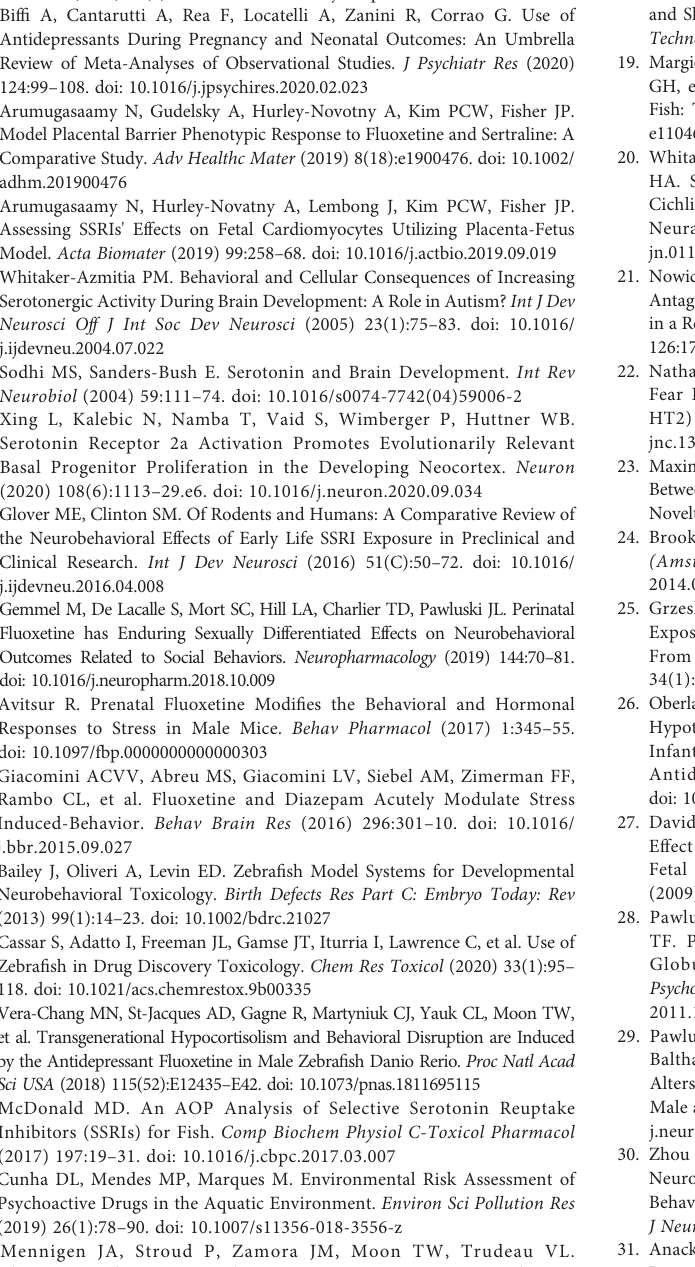
scales of the y-axis are different for unstressed and stressed conditions to illustrate the data points clearly. The blue line shows the adjusted p -value ≤ 0.05 (equal to 1.3 on a negative logarithmic scale). The genes with signi fi cant FC are demonstrated as red dots above the blue threshold line. The genes with the most signi fi cant fold change and the highest signi fi cance are labeled in each graph. L, larval heads; Hyp, hypothalamus; Tel,